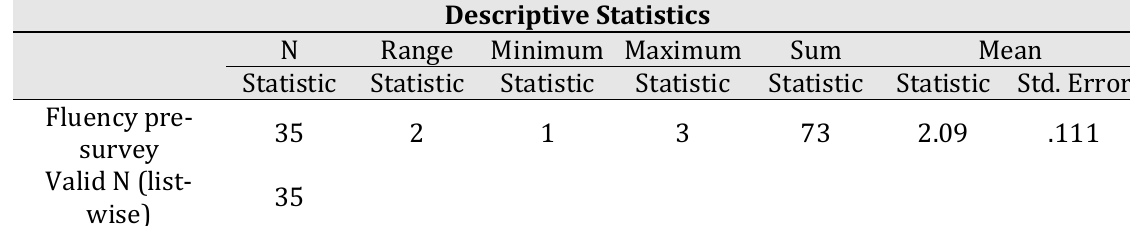
Table 9. Mean Point of Students’ Fluency Pre -test result